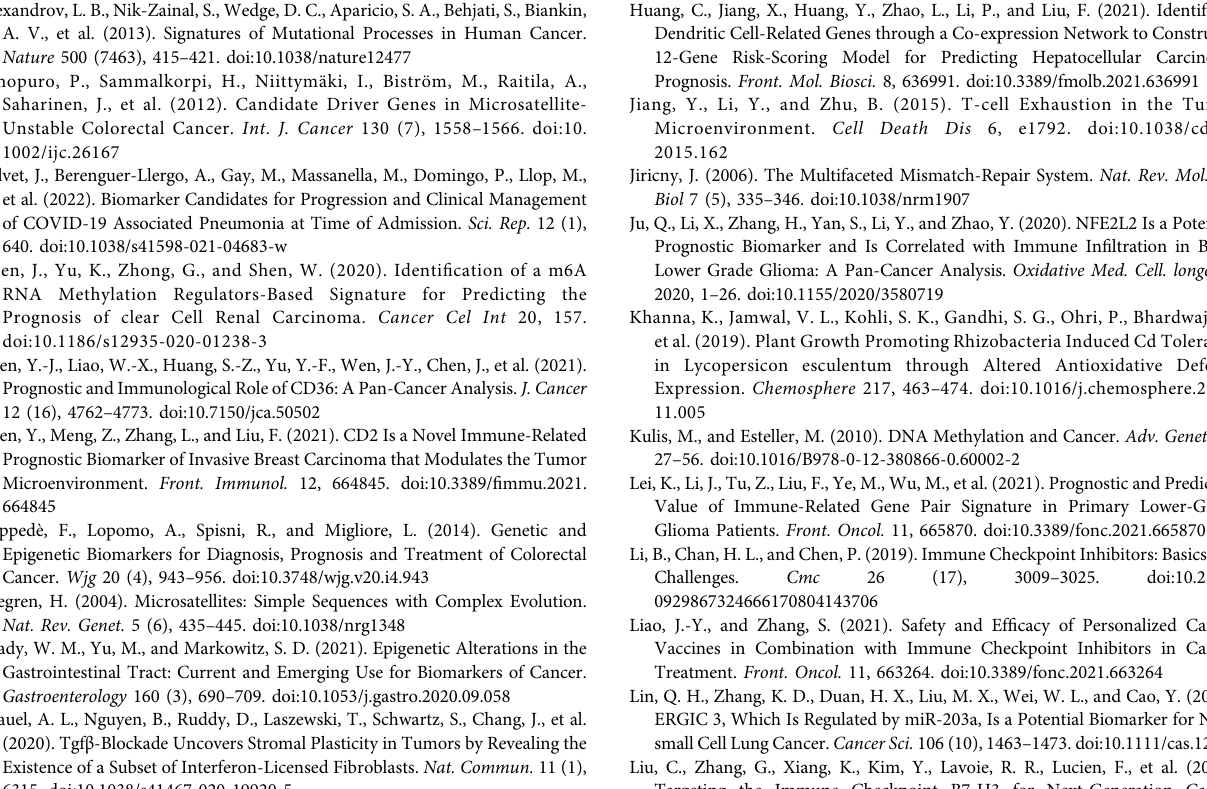
Supplementary Figure 6 | The correlation between OAS3 and immune scores (A) , ESTIMATEScore (B) , and stromal scores (C) in pancancer. Supplementary Figure 7 | Four methods were used to calculate the correlation between OAS3 and immune-related cells. Xcell (A) , TIMER2 (B) , CIBERSORT (C) , and ImmuCellAI (D) . The lower upper triangle of each square represented the magnitude of the p value of the correlation test, and the upper triangle represented the correlation coef fi cient ( p p < 0.05, pp p < 0.01, ppp p < 0.001). Supplementary Figure 8 | (A) OAS3 had a signi fi cant positive correlation with RNA methylation-related genes (m1A, m5C, and m6A) in most tumours. The lower upper